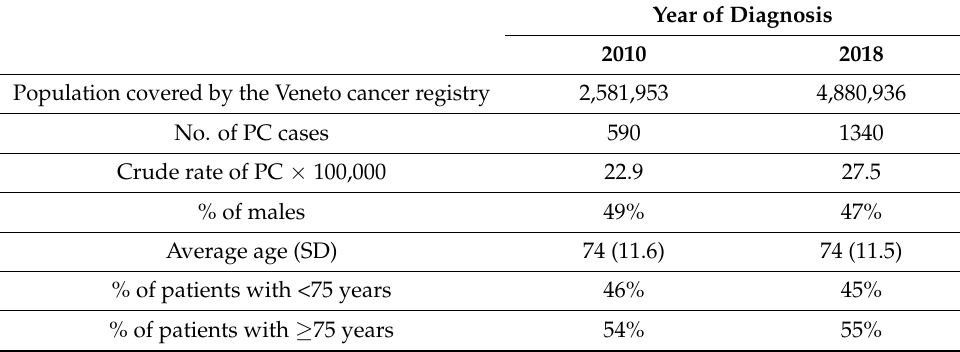
Year of Diagnosis